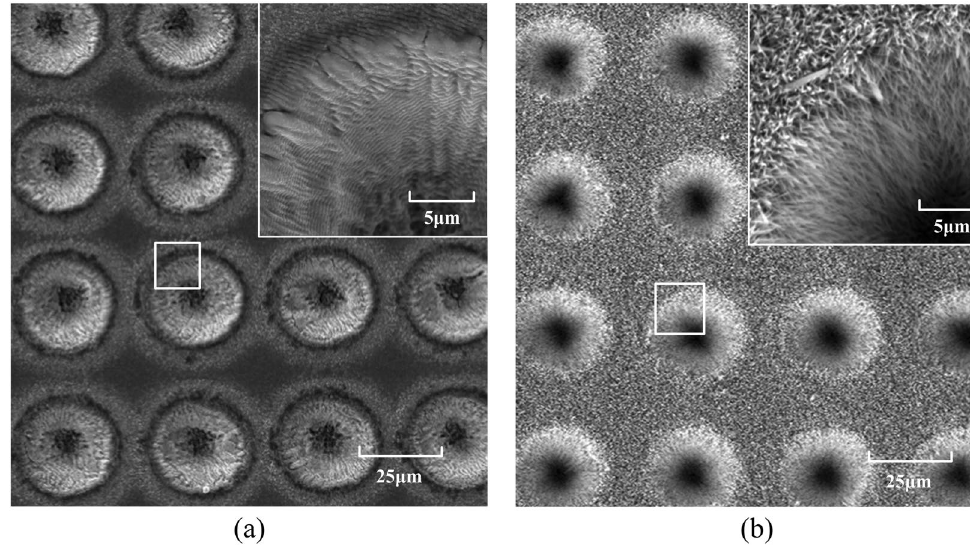
Figure 4. The SEM images of the sample before ( a ) and after ( b ) ZnO nanowires growth.